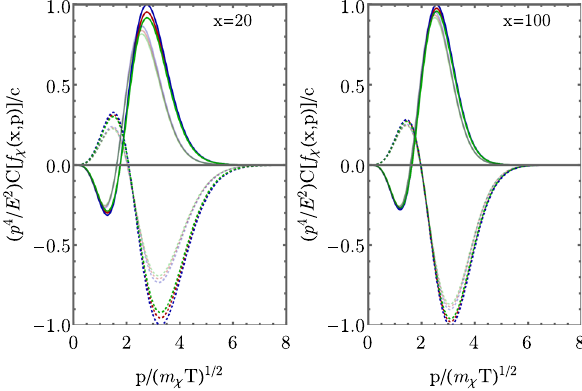
Fig. 12 Same as in Fig. 11, but for a scattering amplitude proportional to Mandelstam t f = ( f 0 , . . . , f N ) T being the momentum-discretized phase- ˆ C el can be written on a momen- space density f χ . The matrix tum grid, with p , ˜ p ∈ { p 0 , . . . , p N } and equal spacing Δ p